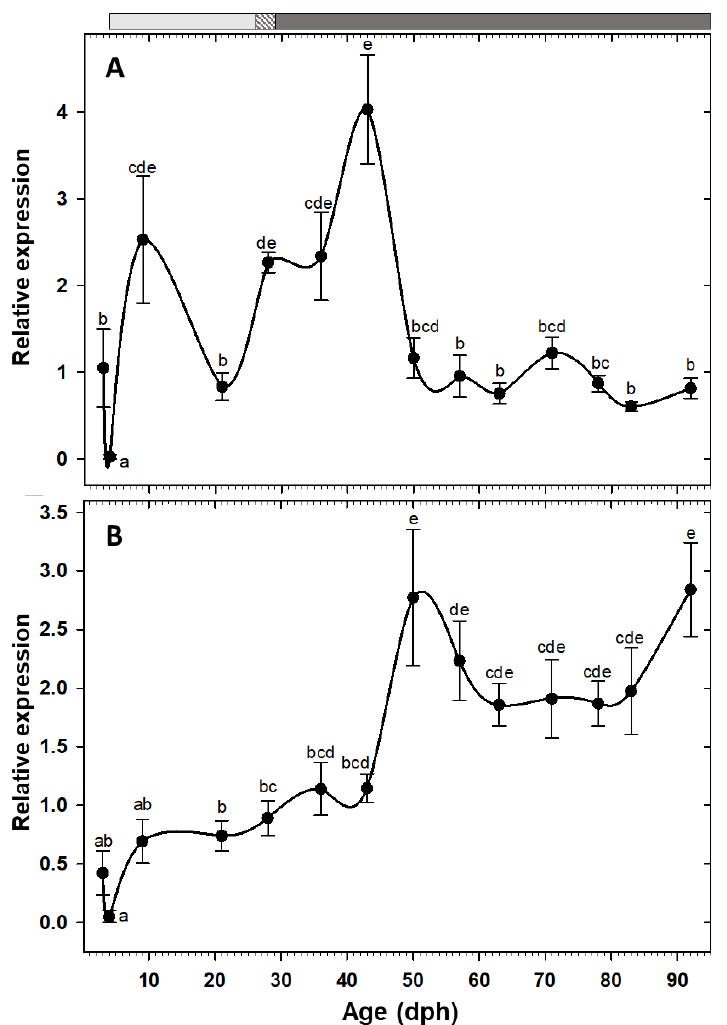
Figure 5. Transcriptional changes of somatotropic factors; gh ( A ) and igf1 ( B ) in whole-body C. labrosus individuals during development (N = 6 to 10 individuals per sampling point). The rest of legend as in Figure 2.